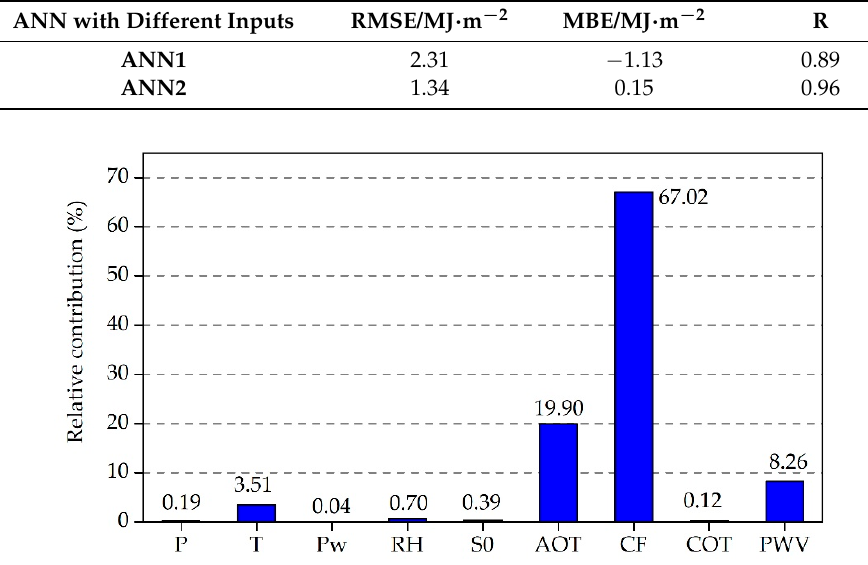
Table 2. Comparison of ANN1 and ANN2.